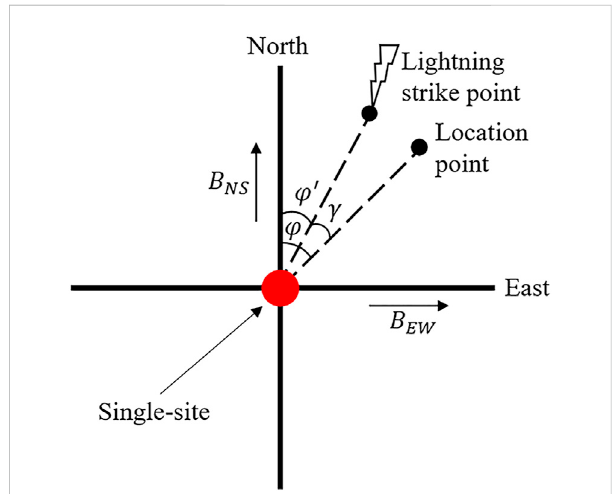
FIGURE 2 Effect of site error on direction